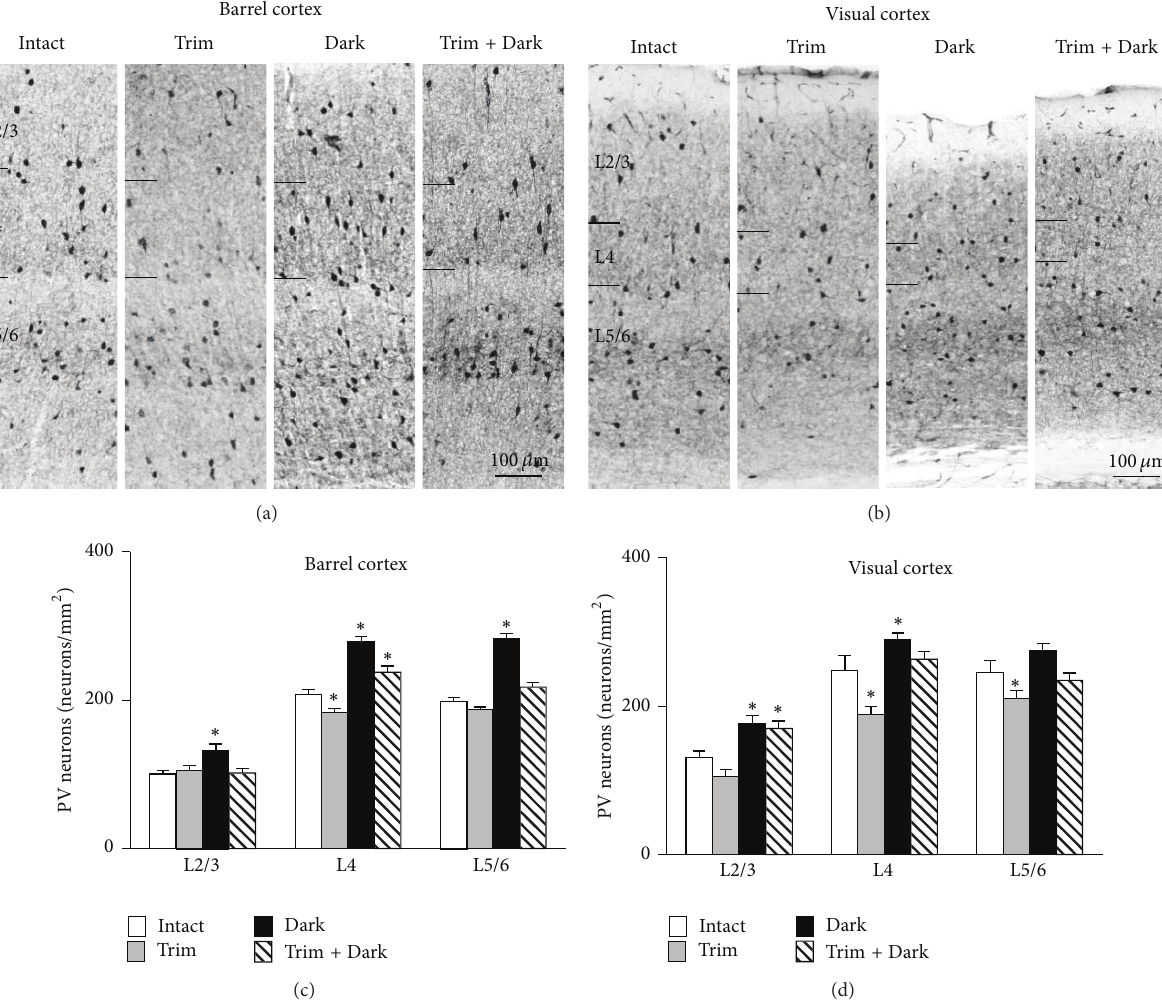
Figure 3: Effects of sensory deprivation on the appearance of PV neurons in the barrel cortex and primary visual cortex. Coronal sections of the barrel cortex (a) and visual cortex (b) stained with anti-PV antibody at P28 are shown. Upper side is the pial surface. Intact: intact control, trim: whisker trimming, dark: dark rearing, and trim + dark: whisker trimming plus dark rearing. Scale bars = 100 𝜇 m (applies to (a), (b)). Changes of the density of PV neurons in each layer of the barrel cortex (c) and visual cortex (d) at P28. Whisker trimming decreased PV neurons in L4 of the barrel cortex. Dark rearing increased PV neurons in L2/3 and L4 of visual cortex. Data are expressed as mean density S.E.M. ( 𝑛 = 6 per group). Abbreviations are the same as in (a) and (b). ∗ 𝑃 < 0.05 compared with intact